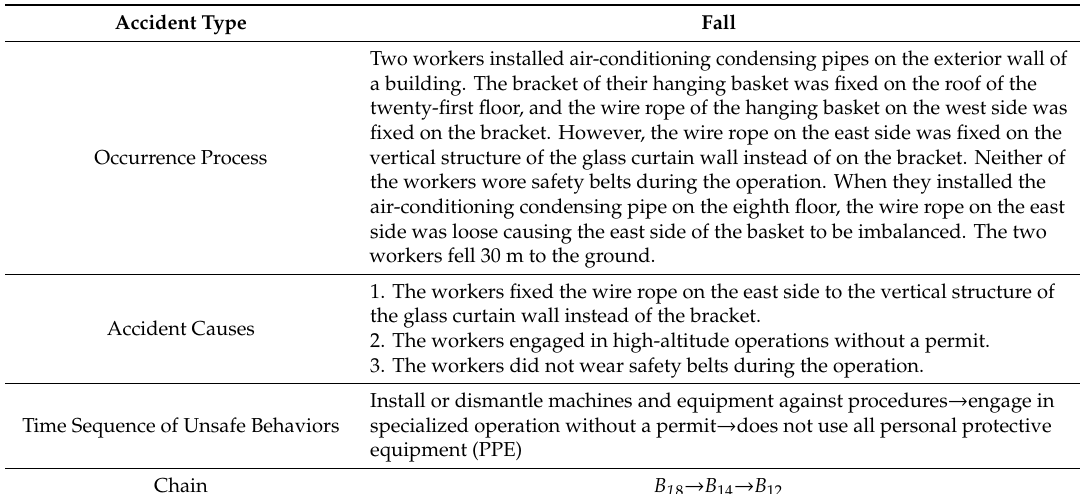
Table 1. One example of extracting a chain of unsafe behaviors in a fall accident.